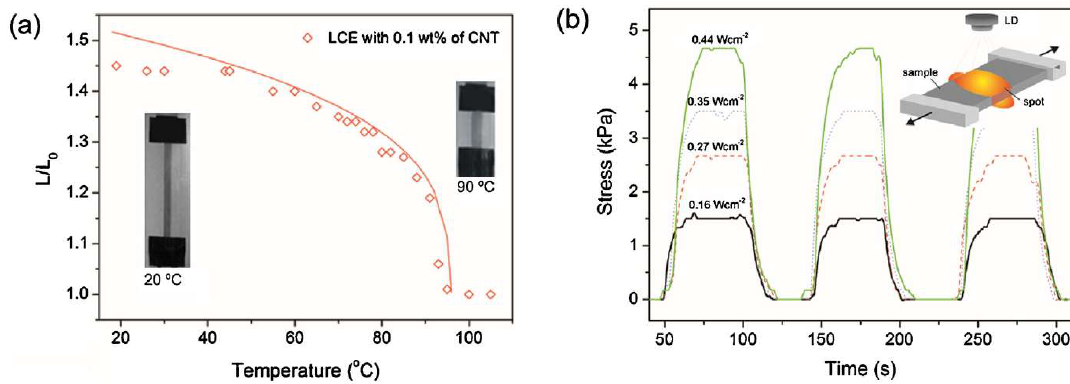
Figure 5. Actuation curves of a stretched LCE sample containing 0.1 wt% of embedded carbon nanotubes (CNTs). ( a ) Contraction ratio (L/L 0 ) under uniform heating measured as a function of temperature. Pictures in the inset demonstrate the contraction/elongation phenomenon at the mesophase transition. ( b ) Actuation-stress curves measured under the application of various power densities. The inset presents the scheme of the set-up used for testing. Adapted with permission from the authors of [43]. Copyright © 2018 Elsevier.